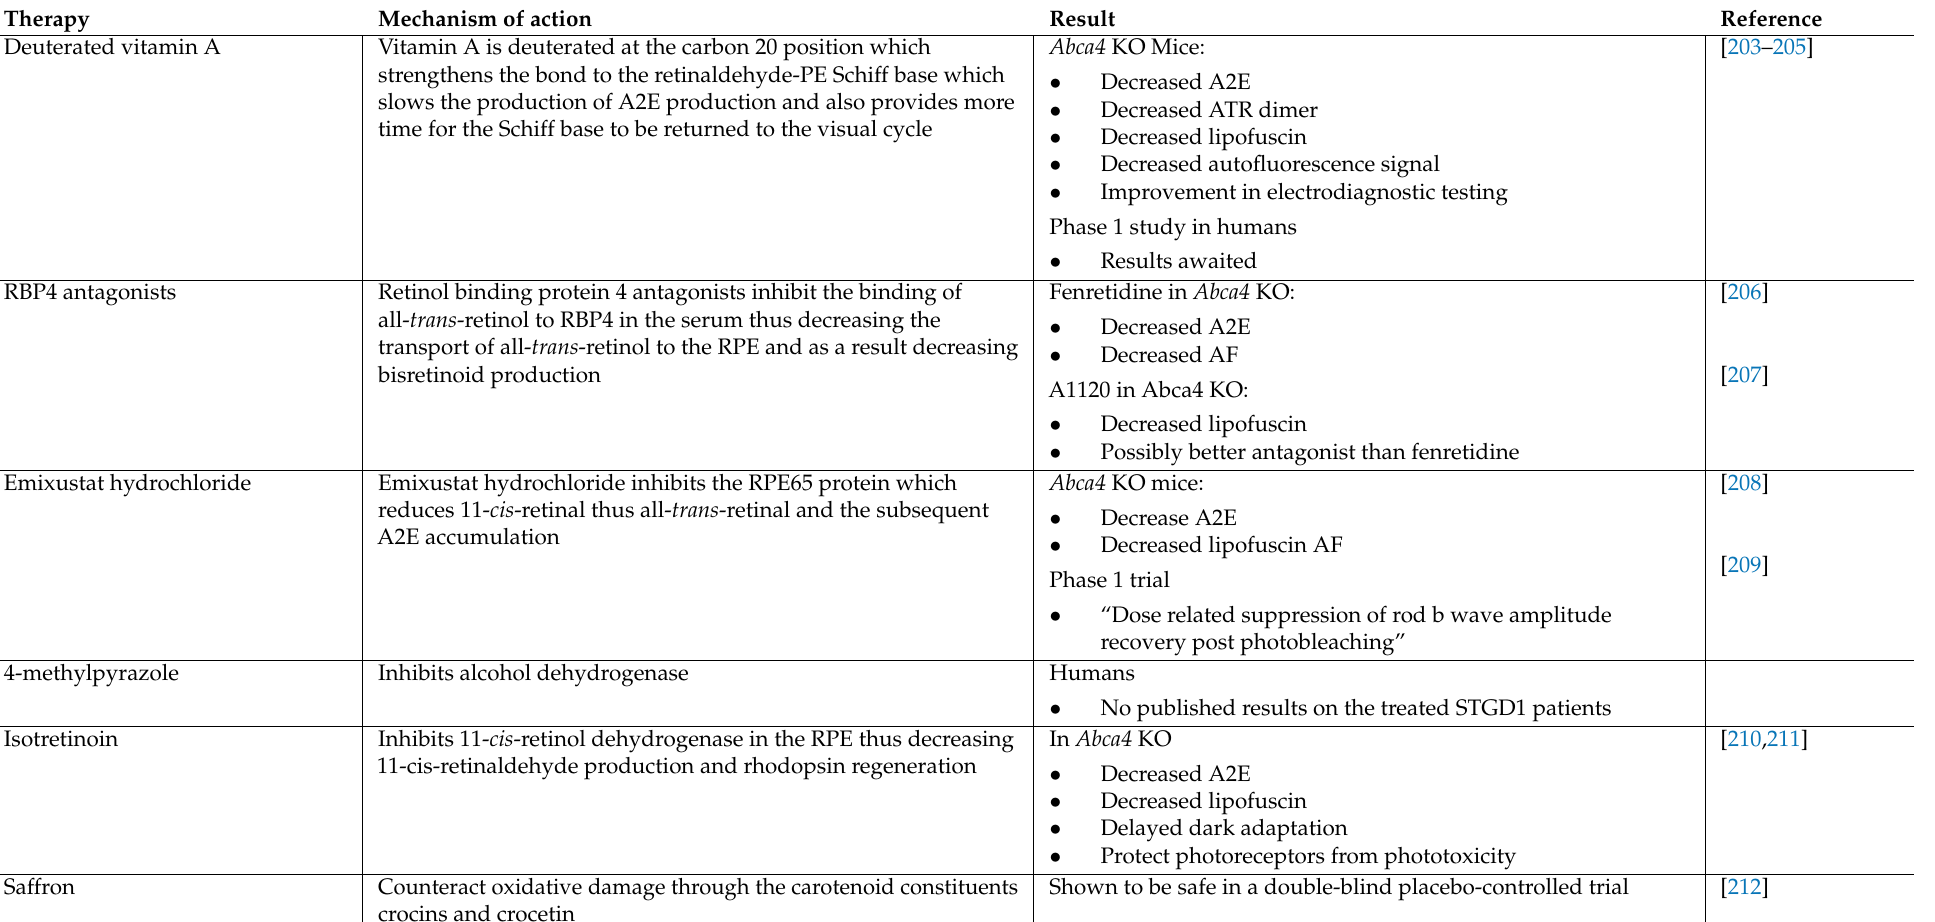
Table 6. A summary of the current pharmacological therapeutic studies in